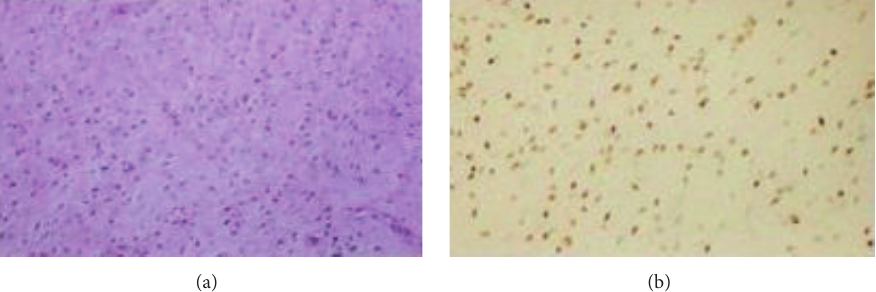
Figure2:(a)HEstain.Aggressiveangiomyxoma:evenlydistributeddelicatespindlecellsgrowinamyxoidmatrix.(b)Immunohistochemical stains for smooth muscle actin, estrogen, and progesterone receptors are